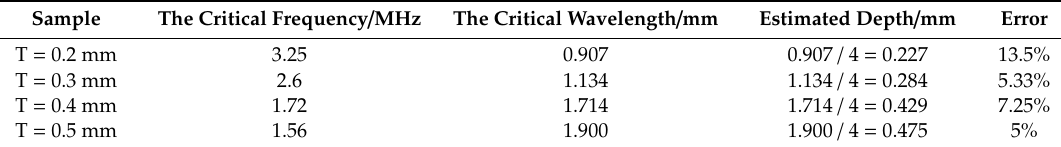
Table 8. Estimated depth and relative error for C.